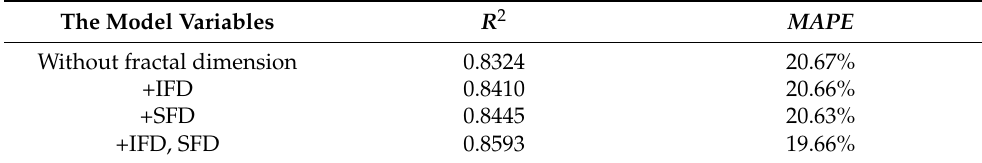
Table 5. R 2 and MAPE for the dry weight model.